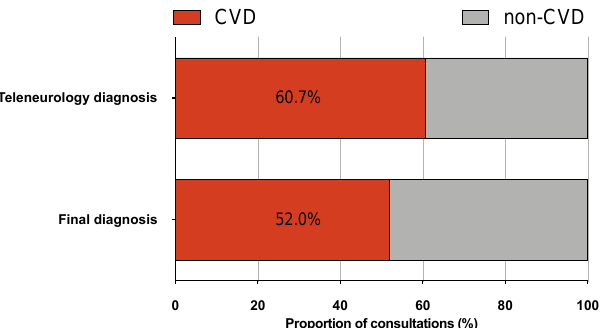
Figure 3. Frequency of cerebrovascular disease vs. other diagnoses after initial teleneurological consultation and at discharge. CVD, cerebrovascular